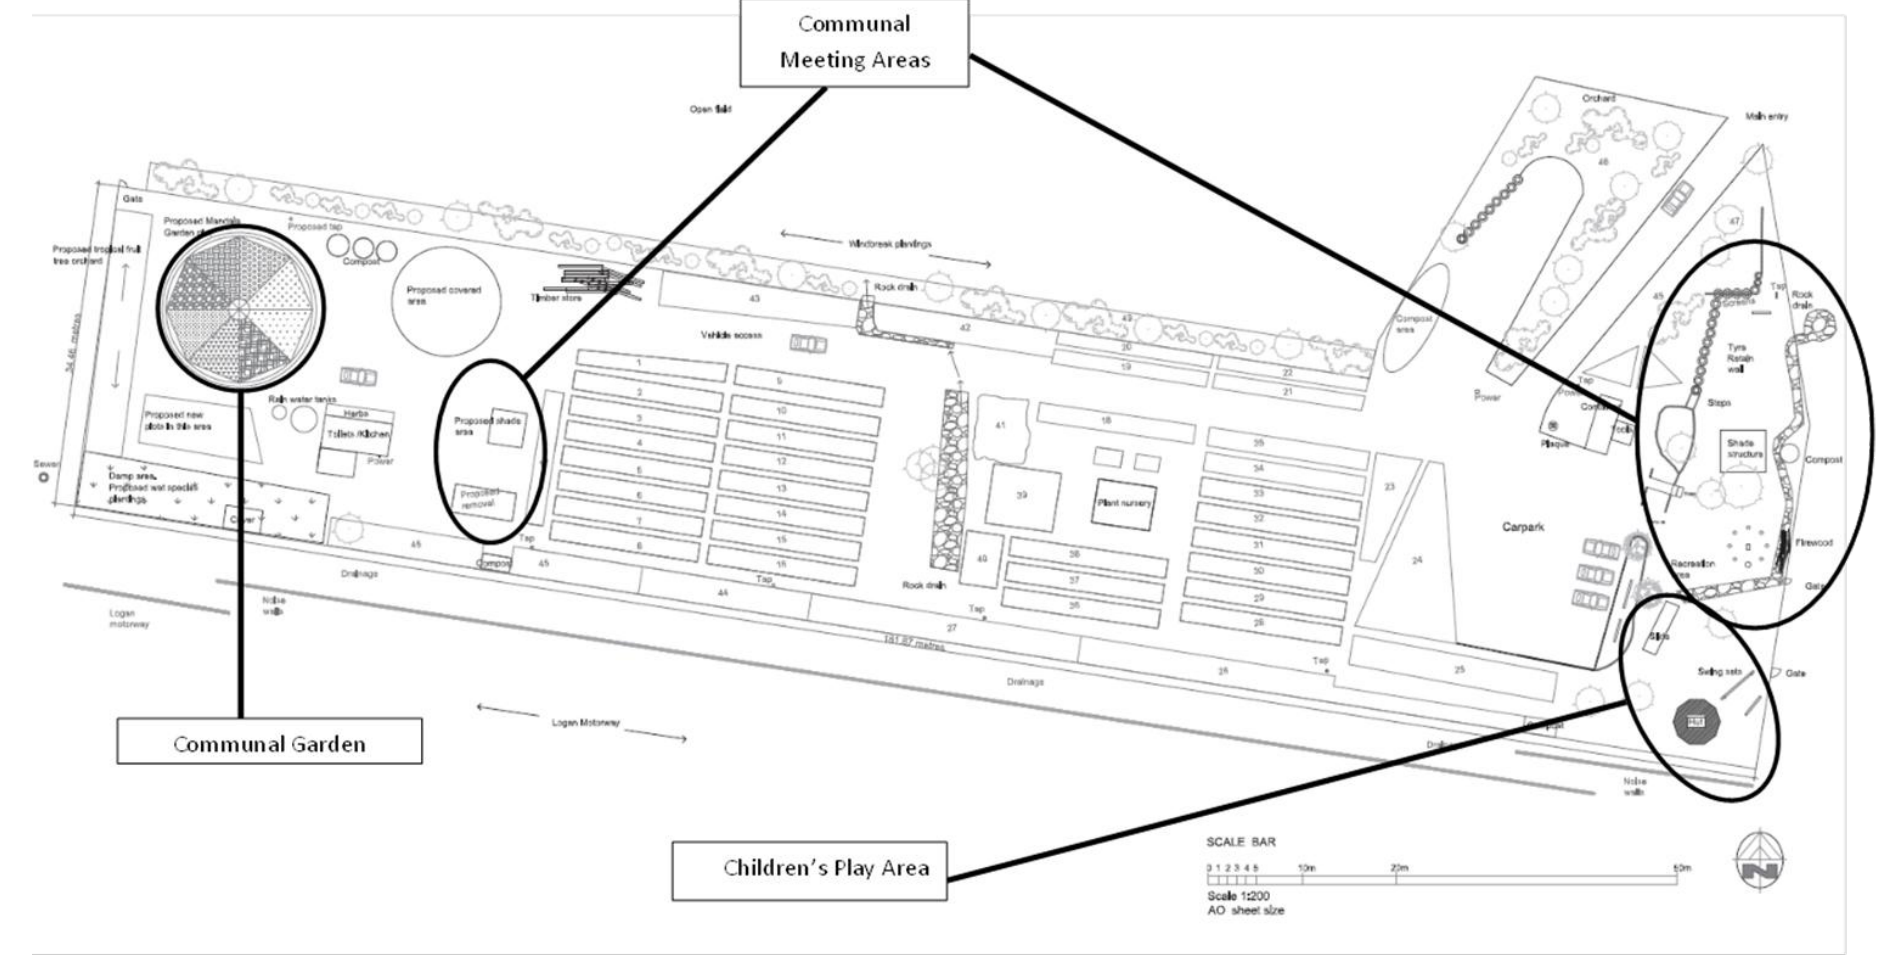
Figure 2. Logan Campus Based Community Food Garden